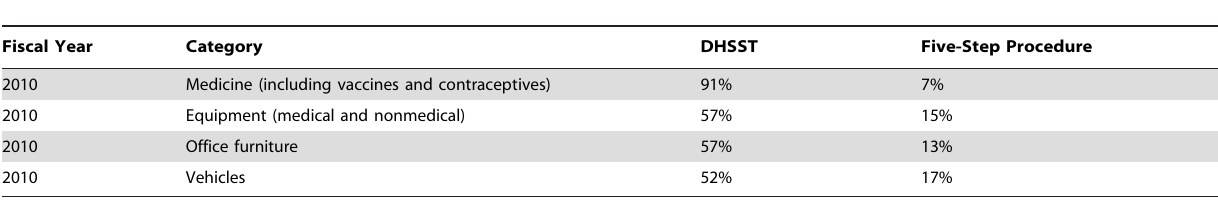
Table 2. Missing proportions of in-kind donations in the 21 health